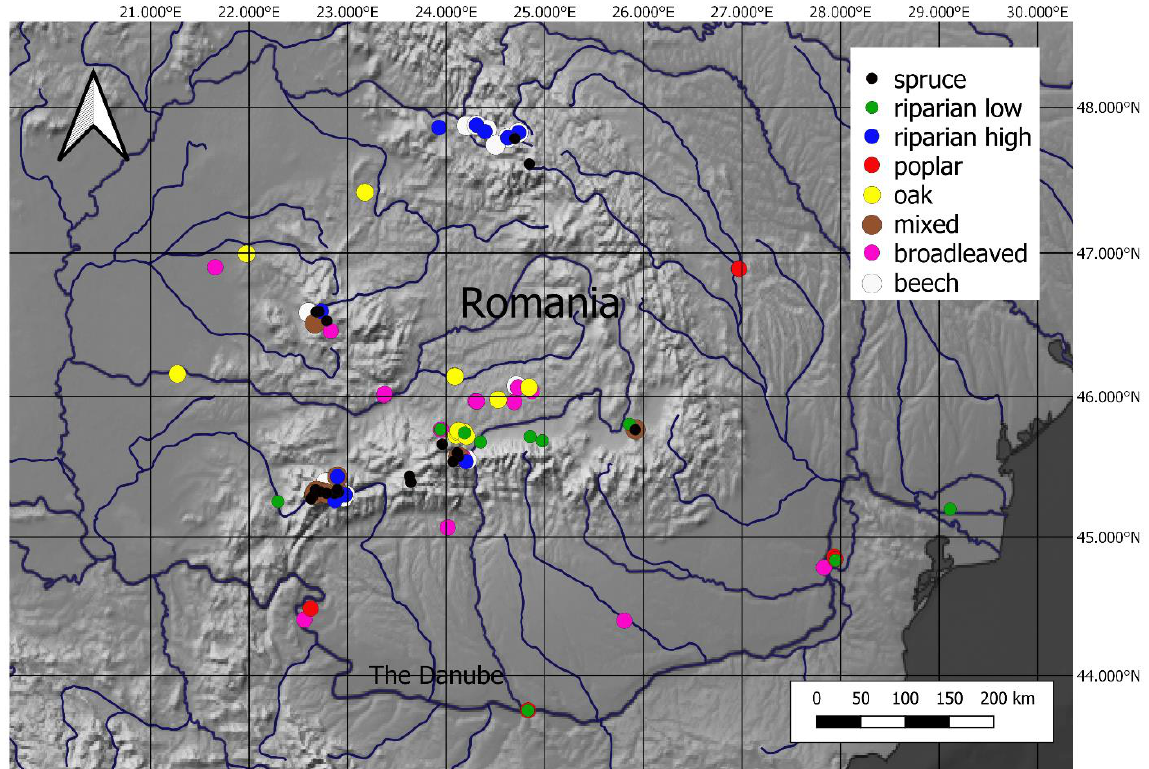
Figure 1. Location of sampled forests.